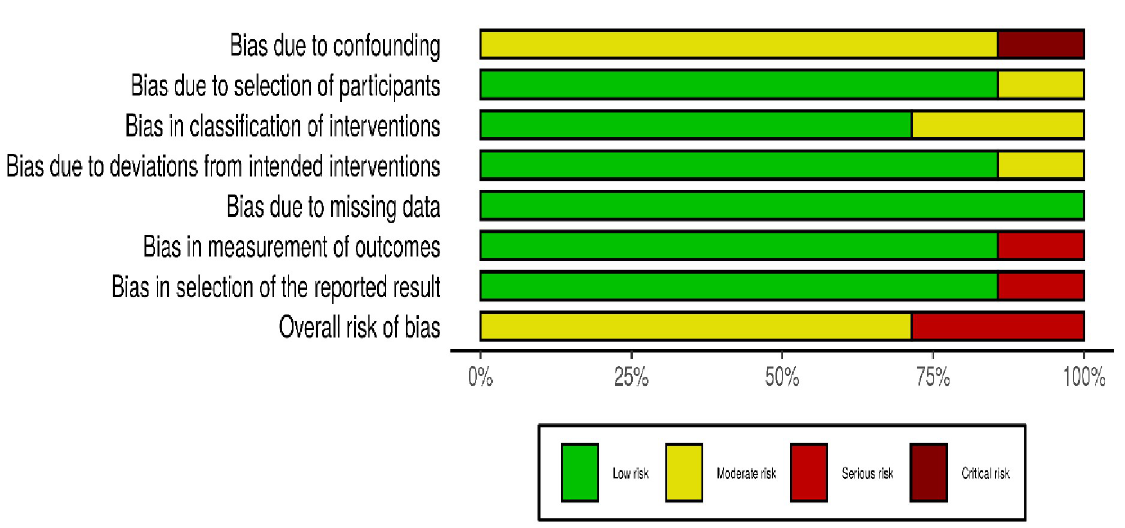
Fig 3. Bar diagram for each risk of bias domains in ROBINS-I for the selected